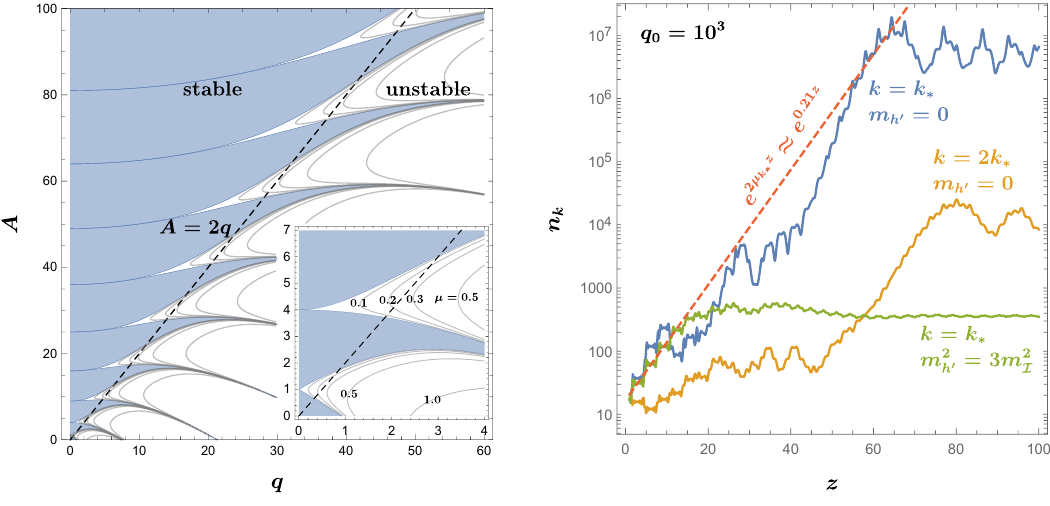
Figure 2 . Left : the stability diagram for the Mathieu equation in the plane of q and A . For the unstable region, exponential growth solutions are expected with the exponential index (cid:22) = 0 : 1 ; 0 : 2 ; 0 : 3 ; 0 : 5 ; 1 : 0 from left to right shown in the gray contour lines. Right : solution to the linearized equation of motion for (cid:14)’ 1 expressed as the growth of the comoving number density n k , showing the e(cid:11)ect of varying k in terms of k (cid:3) ’ m I q 1 = 4 to the solution for (cid:14)’ 2 ; 3